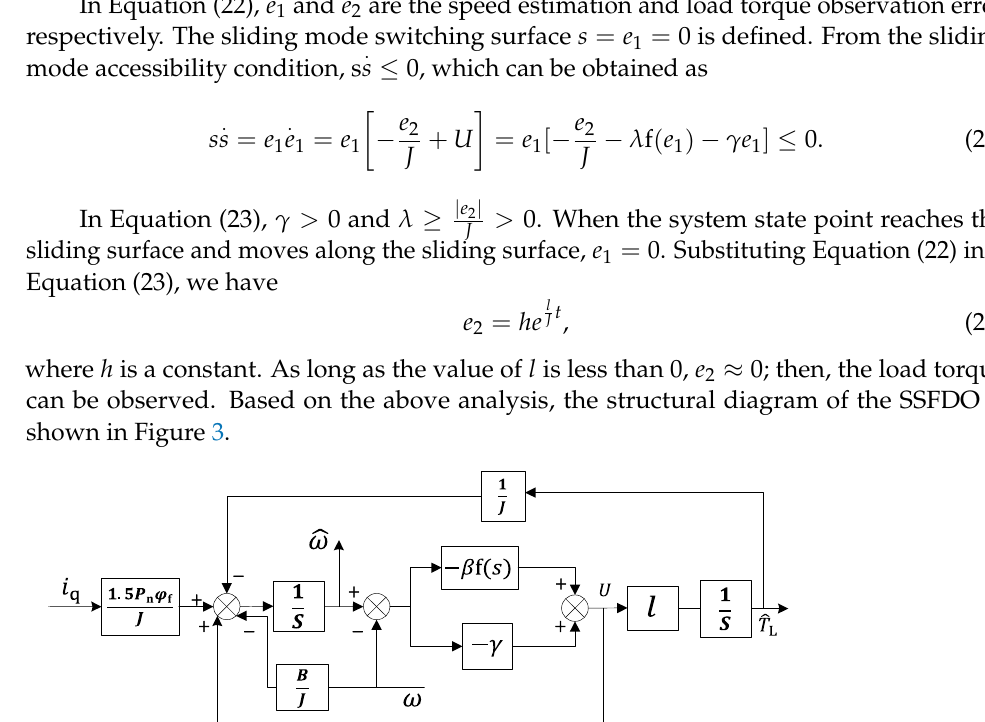
Figure 3. Structure diagram of the symmetric S-type function disturbance observer (SSFDO).